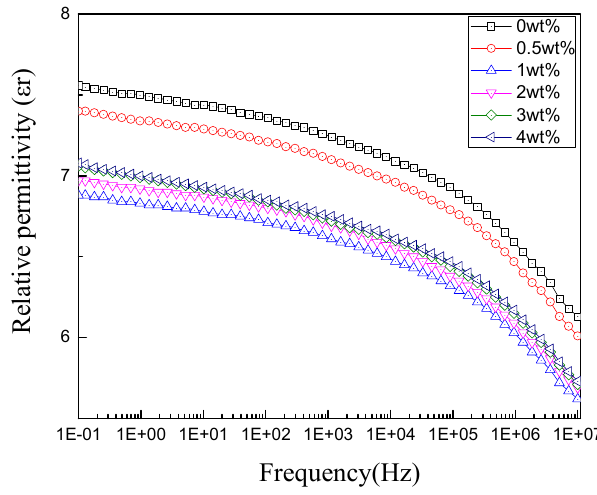
Figure 10. ε r versus frequency curves of RIP with different nanoparticle components.